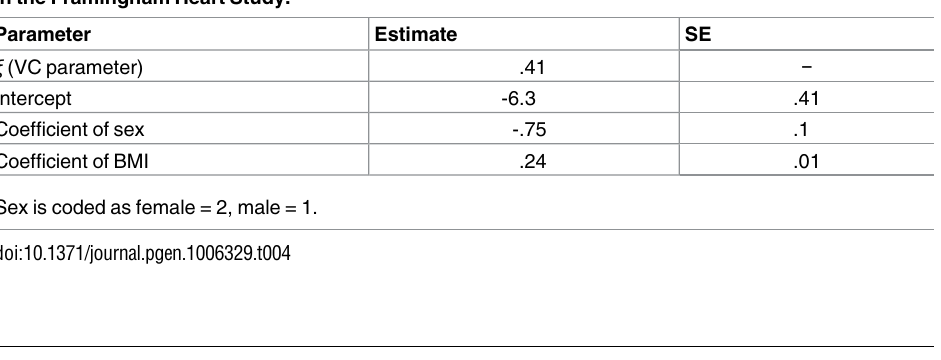
; ^ β Þ , in the Null Phenotypic Model of CERAMIC, for Type 2 Diabetes 0 0